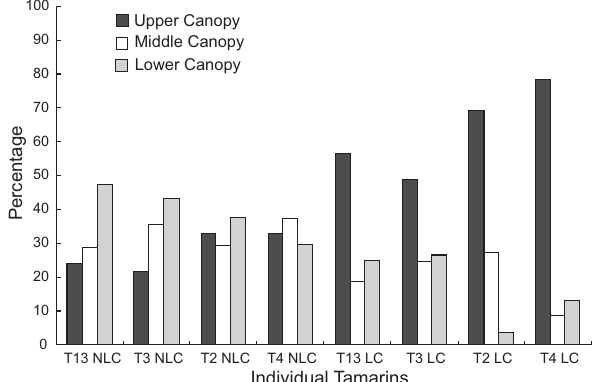
Figure 1. Mean percentage utilization of forest strata (upper, middle or lower stratum) by the reproductive pair (males: FT13, ST3; fe- males: ST2, FT4) of two groups (Funil-F and Saquarema-S) of golden lion tamarins ( Leontopithecus rosalia ) when they were emitting (LC) or not emitting long calls